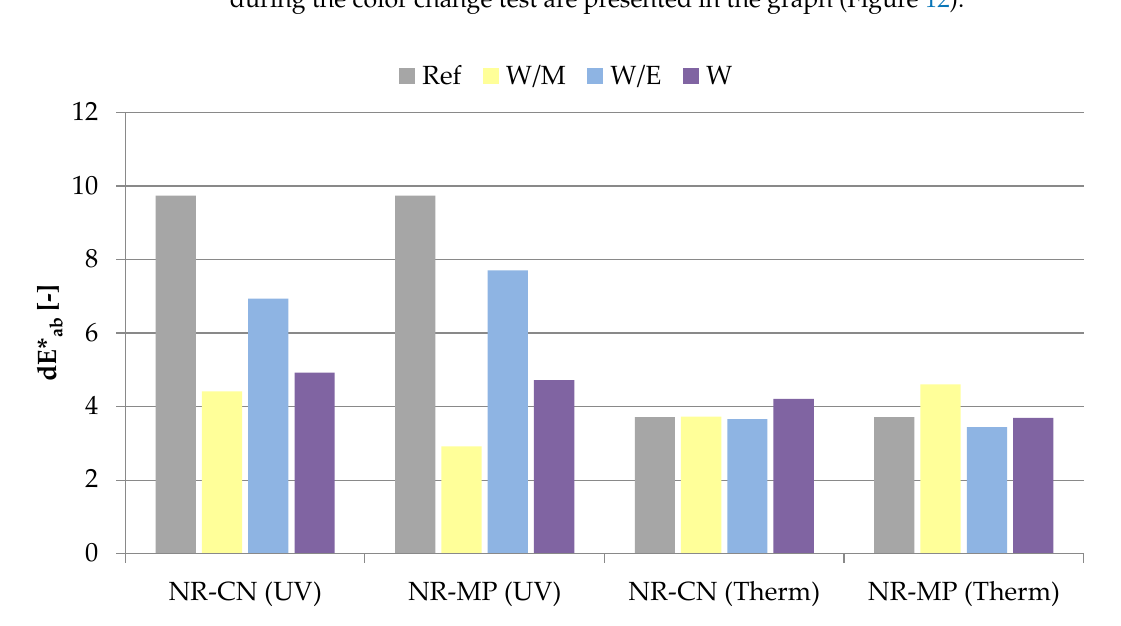
Figure 12. The color change parameter (dE* ab ) of samples after ultraviolet (UV) and thermo-oxidative (Therm) aging.